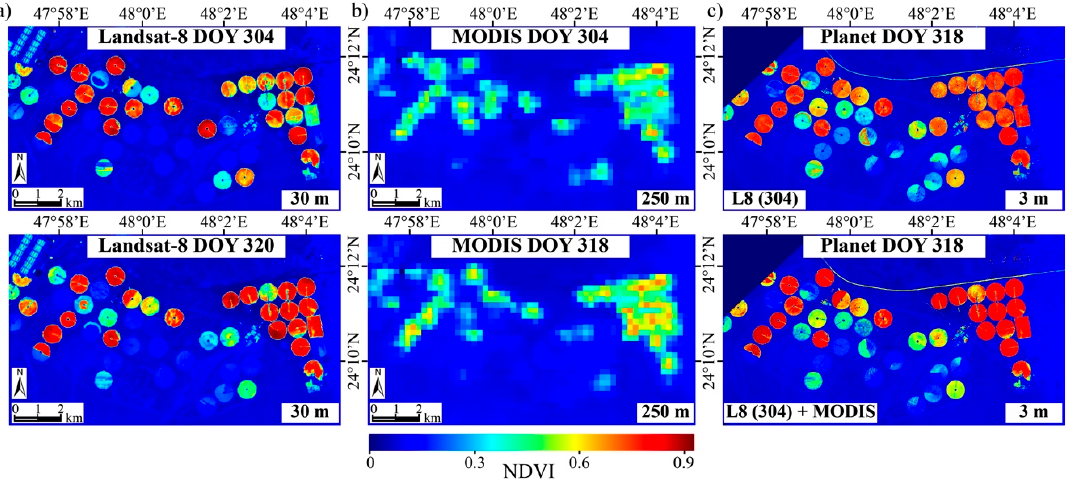
Figure 4. ( a ) Landsat-8 NDVI on DOY 304 (top) and 320 (bottom). ( b ) Day-specific (i.e., interpolated) MODIS NDVI on DOY 304 (top) and 318 (bottom). ( c ) Planet NDVI on DOY 318 predicted on the basis of Landsat-8 NDVI from DOY 304. The bottom plot demonstrates the utility of using higher frequency MODIS data to inform the Cubist-based regression models when near-coincident Landsat and Planet acquisitions do not exist.